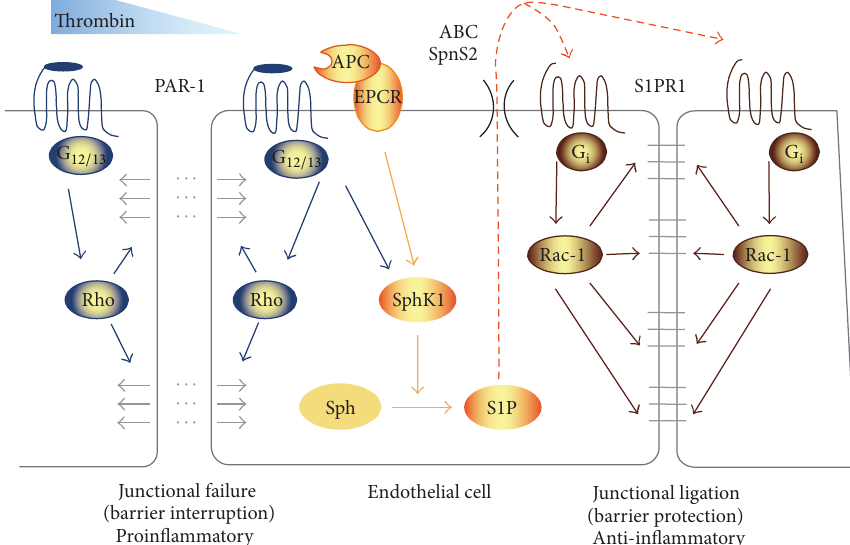
Figure 2: Thrombin effects in endothelial cells involve S1P signaling. Activation of the classical thrombin receptor PAR-1 interrupts endothelial barrier integrity by induction of endothelial contraction through stimulation of G 12/13 subunit and Rho signalling pathway (left). Conversely, thrombin also induces expression of SphK1 and increases S1P generation. This involves PAR-1-induced signaling via activated protein C (APC) and the endothelial protein C receptor (EPCR). S1P in turn transactivates S1PR1 leading to G Rac-1signalingpathway.Thiseffectimprovesendothelialintegritytocounteractandlimitthrombin-inducedendothelialdamageandvascular leakage